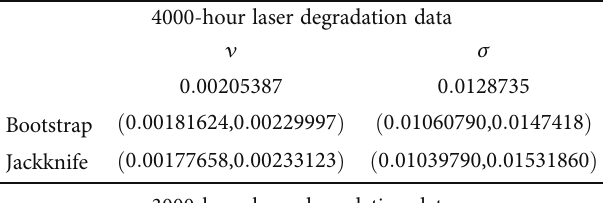
Table 5: Wiener degradation path parameter estimates and 95% con fi dence intervals.